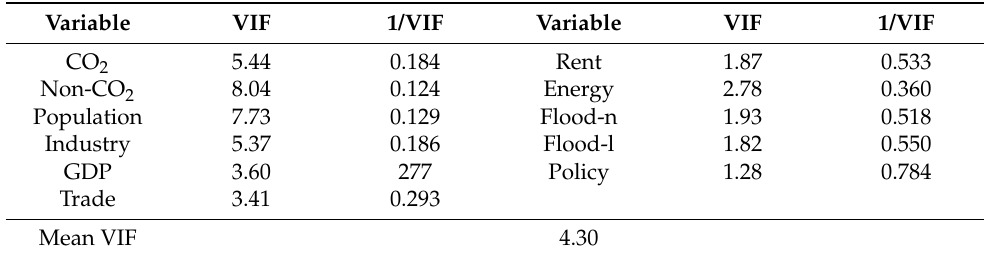
Table 3. VIF regression collinearity test.